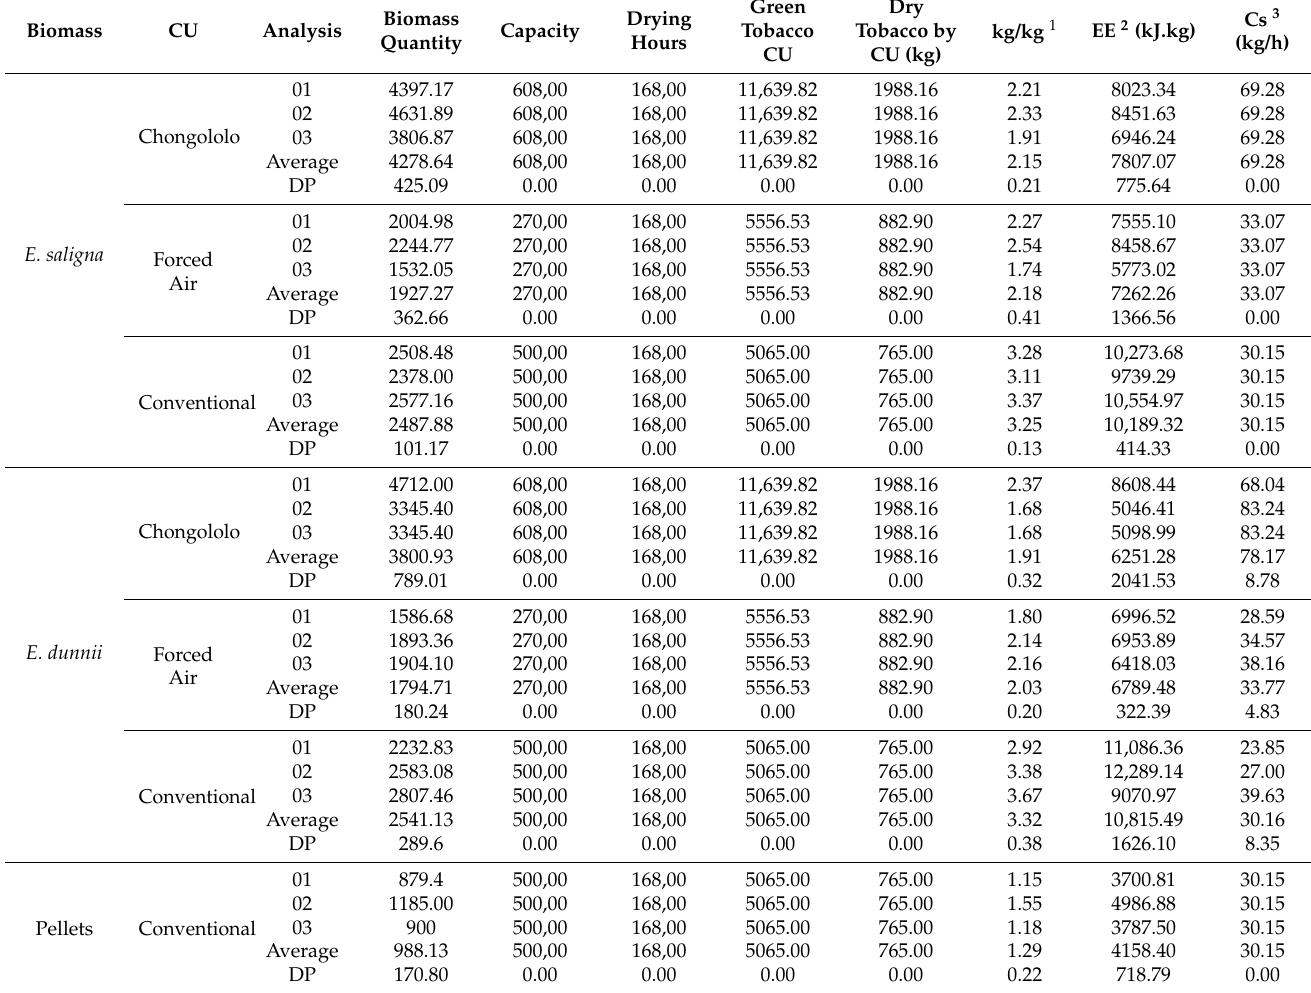
Table A1. Detailed data of forest biomass types studied in the different curing